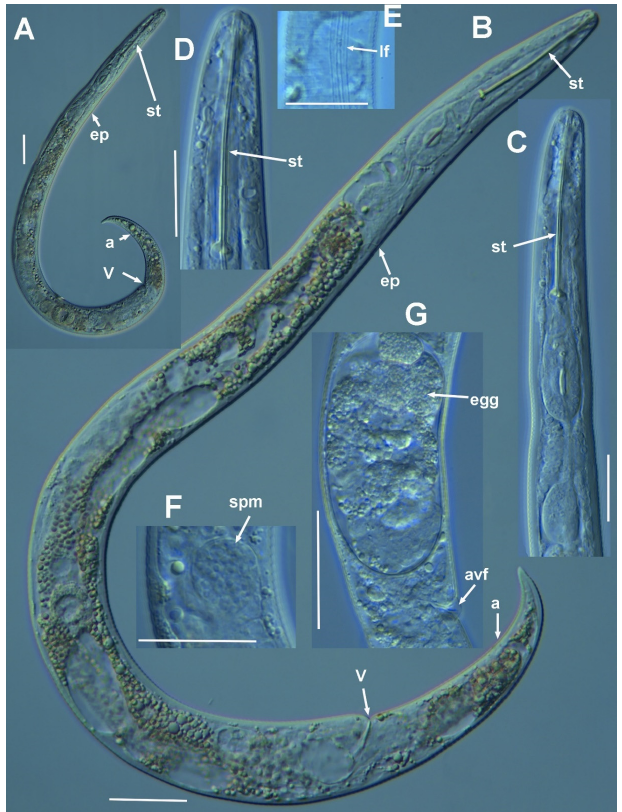
Figure 5. Micro-photomicrographs of Paratylenchus plesiostraeleni sp. nov. female. ( A , B ) Whole female with stylet, excretory pore and vulva arrowed; ( C ) pharyngeal region; ( D ) Stylet region; ( E ) Detail of lateral fields; ( F ) Detail of spermatheca; ( G ) Detail of vulva showing advulval flap (arrowed) and egg (arrowed). Scale bars ( A – G = 20 µ m). (Abbreviations: a = anus; avf = advulval flap; egg = egg; ep = excretory pore; lf = lateral field; spm = spermatheca; st = stylet; V = vulva). Plants 2022 , 11 , x FOR PEER REVIEW